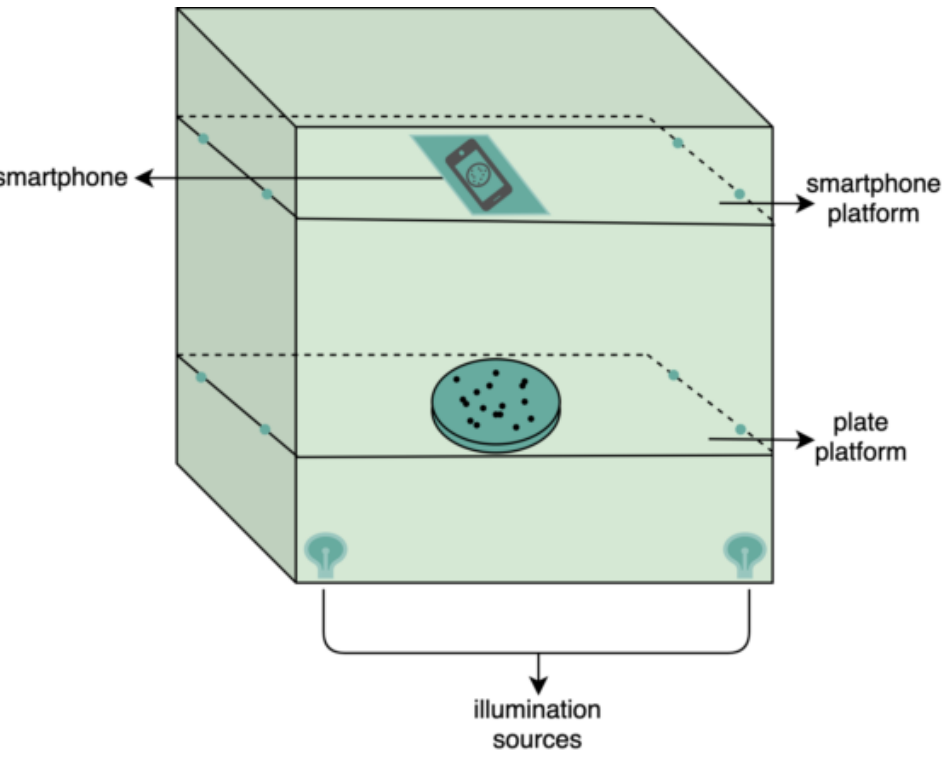
Figure 2. Scheme of the handled black box to image